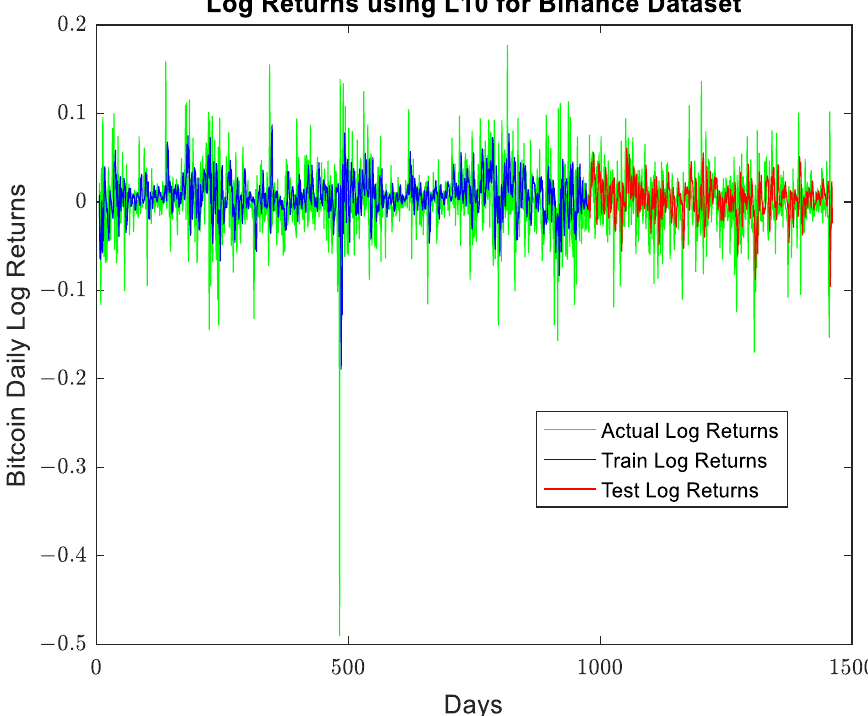
Figure 15. Training, testing and actual Bitcoin log returns of Legendre-based neural network model using proposed dual normalized Binance dataset .